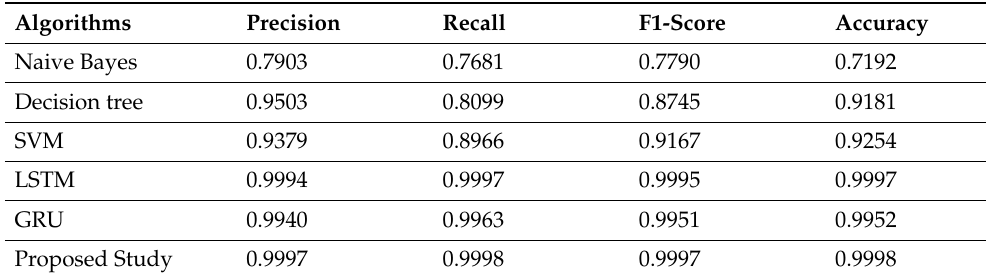
Table 5. Comparison of the HDL-IDS with other ML algorithms on the car-hacking 2020 dataset.